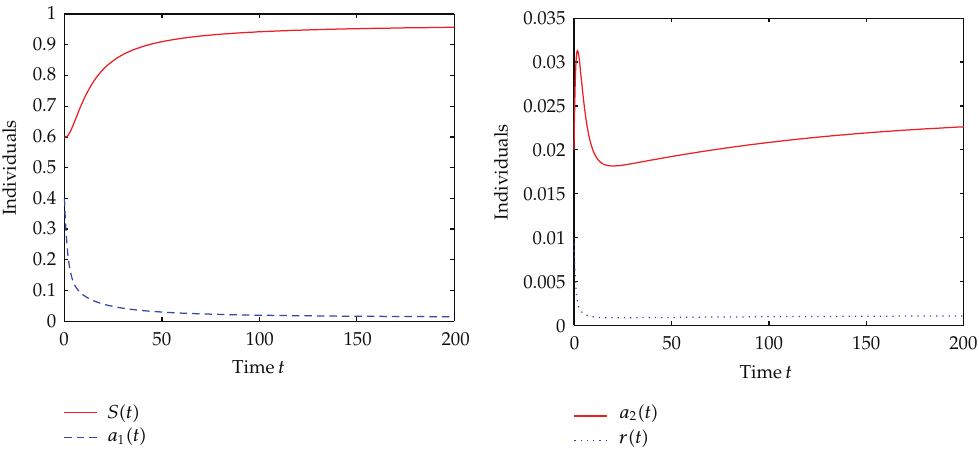
Figure 3: When p (cid:6) 0 . 1, α (cid:6) 0 . 4, and R 0 (cid:6) 1 . 8031 > 1, the alcohol-present equilibrium E ∗ is globally asymptotically